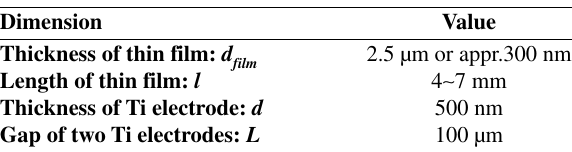
Table 1. Dimensions of the parallel electrode device for transporta- tion measurement Dimension